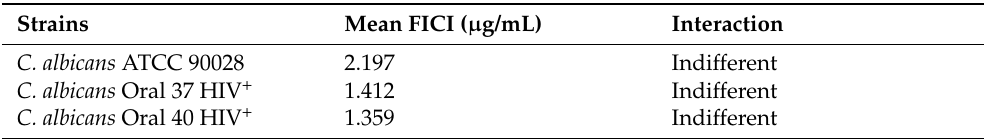
Table 5. Individual fractional inhibitory concentration indexes (FICIs) for different sub-inhibitory concentrations of sulforaphane (SFN; 0.12–30 µ g/mL; MIC/256-MIC/2) and fluconazole (FLZ; MIC/2: 0.5 µ g/mL for ATCC 90028, 1 µ g/mL for Oral 40 HIV + , and 4 µ g/mL for Oral 37 HIV + ). FIC ( µ g/mL) at an SFN Concentration ( µ g/mL) of: Strain FLZ MIC/ MIC/ MIC/ MIC/ ( µ g/mL) 256 128 ATCC 90028 Oral 37 HIV + MIC/4 - - Oral 40 HIV + MIC/4 0.253